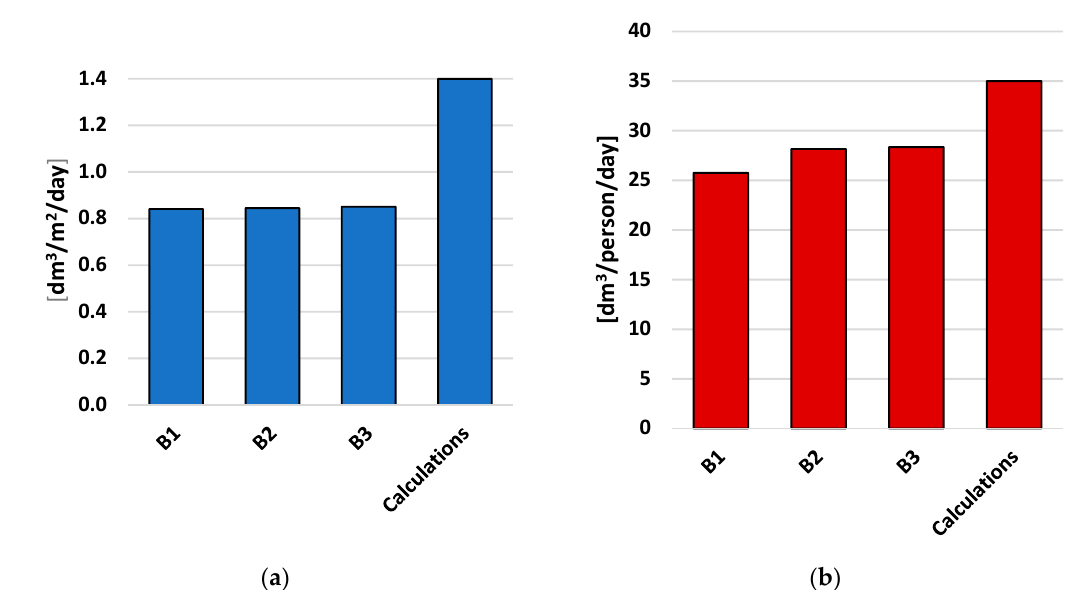
Figure 6. Results of DHW consumption rate calculations compared with the values obtained when calculating the energy ratings of buildings in Poland. ( a ) Domestic hot water consumption in real buildings; ( b ) Domestic hot water consumption in real buildings